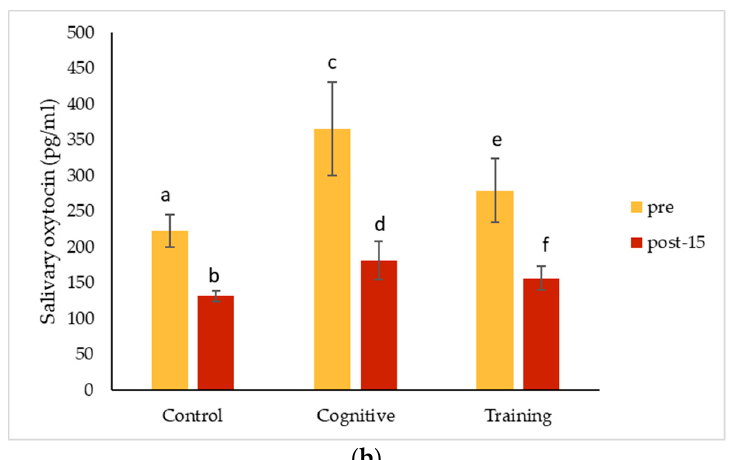
Figure 6. Salivary oxytocin (mean ± standard error) before and after two types of human–animal interactions and a control condition for ( a ) Pende and ( b ) Kongo. Friedman tests comparing the change in hormone levels (calculated by subtracting the pre from the post-15 values) across conditions were non-significant for each gorilla. Bars with different letters within a condition are significantly different or trending at p < 0.10 comparing time points within that condition based on Wilcoxon signed rank tests with Monte Carlo sampling.